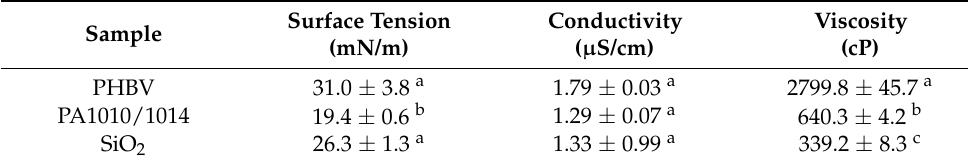
Table 2. Properties of the PHBV, PA1010/1014 solution, and SiO 2 dispersion.